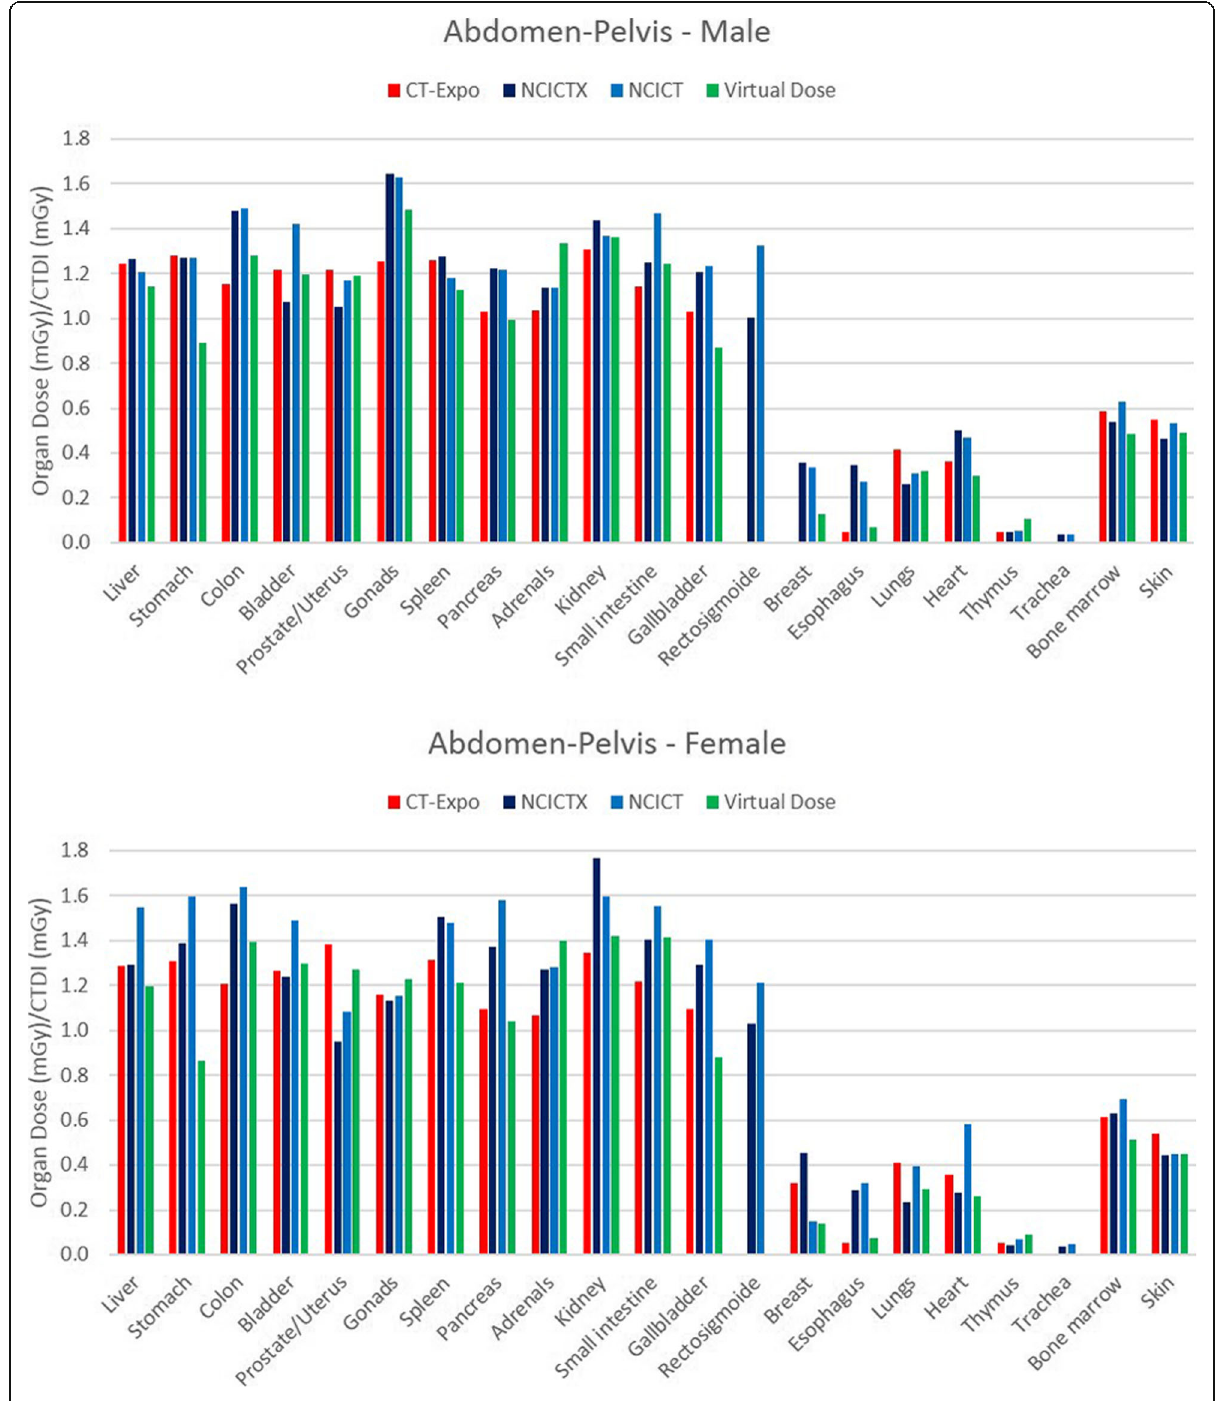
Fig. 5 Organ dose per volume computed tomography dose index (CTDI vol ) unit, obtained simulating the CT abdomen-pelvis protocol with CT- Expo, NCICTX, NCICT, and Virtual Dose, using a male and female phantom. These values are dose coefficients, obtained as organ dose (mGy) and CTDI vol (mGy) ratio. Liver, stomach, colon, bladder, prostate/uterus, gonads, spleen, pancreas, adrenals, kidneys, small intestine, gallbladder, and rectum are completely irradiated. Only NCICTX and NCICT consider trachea and rectum. CT-Expo considers the breasts only for the female